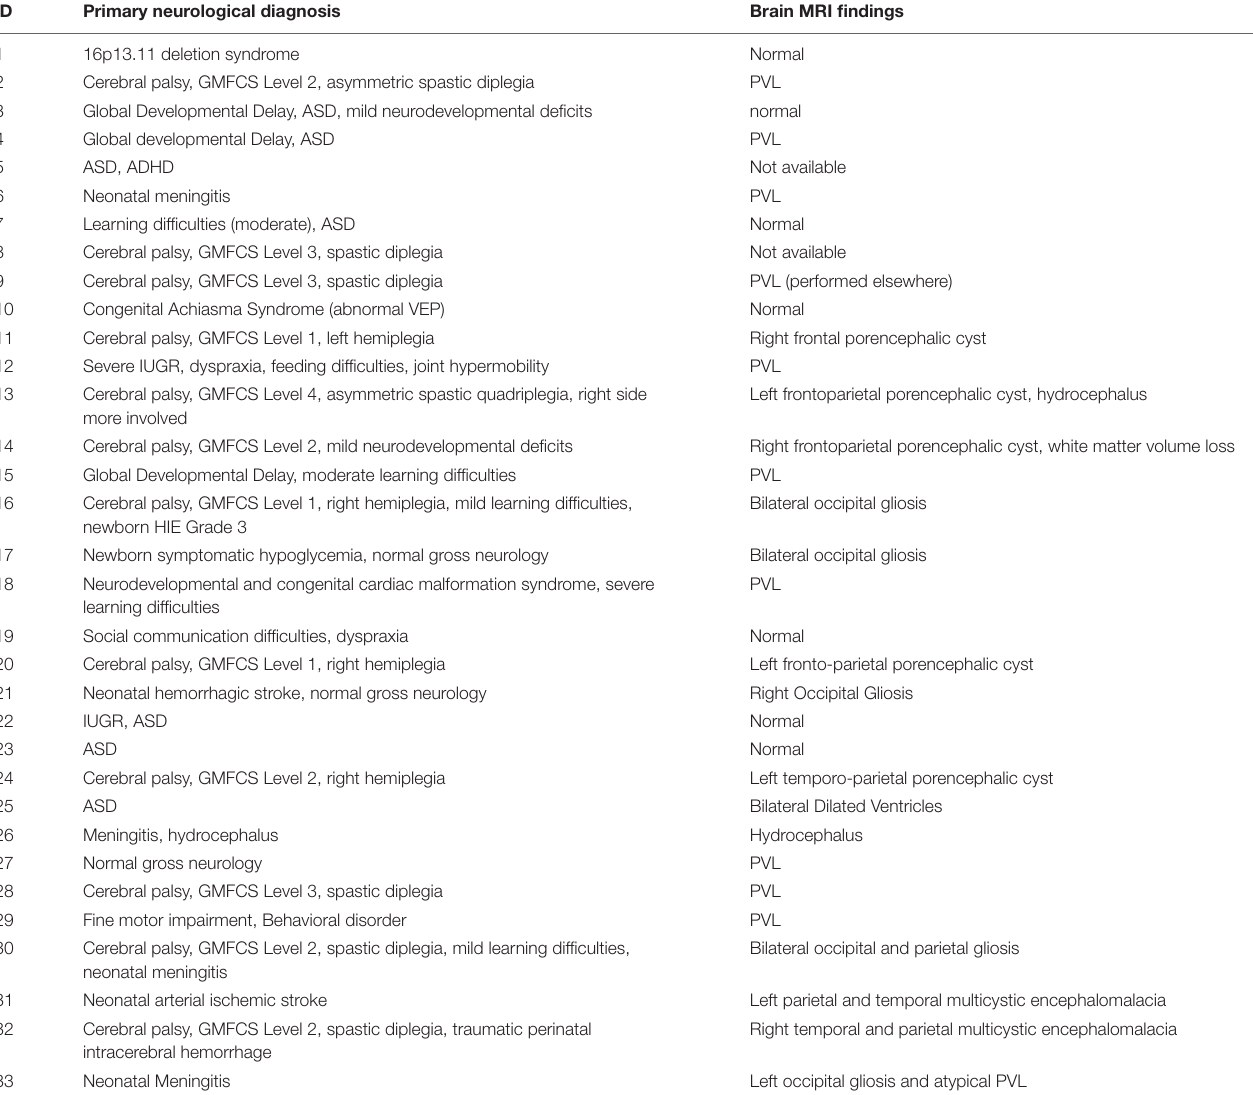
TABLE 2 | Neurological summary diagnoses and Brain-MRI scan results of children with CVI.